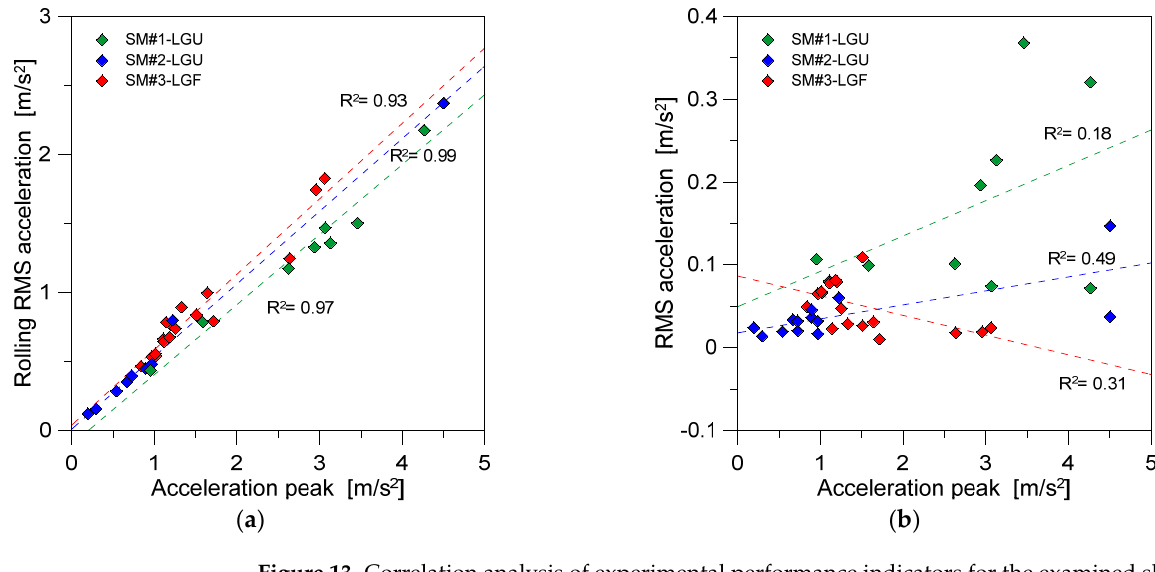
Figure 13. Correlation analysis of experimental performance indicators for the examined slab units: ( a ) rolling RMS acceleration as a function of the vertical acceleration peak; and ( b ) RMS acceleration as a function of the vertical acceleration peak.